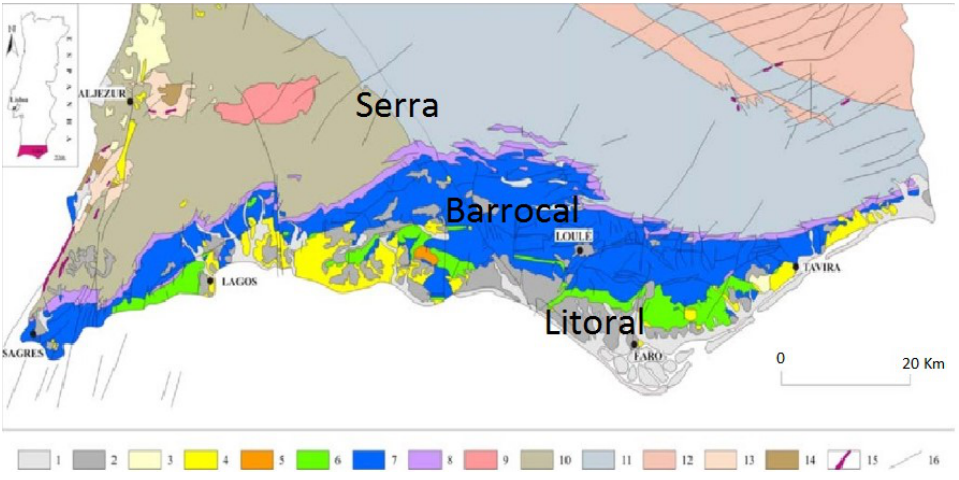
Figure 3: Geological map of